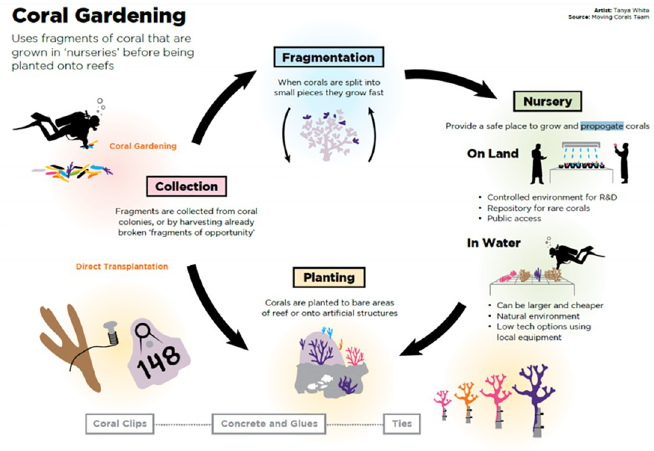
Fig 2. The coral gardening process involves the collection of coral fragments, fragmentation, a nursery phase on land or in water, and an (out)planting phase.